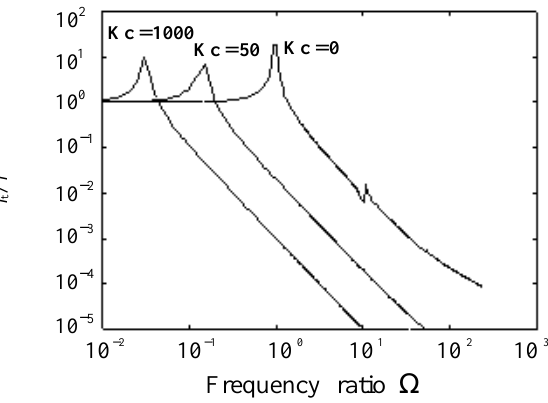
Fig. 2. Comparison of the magnitudes of the force transmitted to the passive and hybrid isolation systems ( µ = 0 . 5 ,ω 1 /ω 0 = 10 , γ = 2 ,δ = 0 . 001 ,ξ = 0 . 01 ).